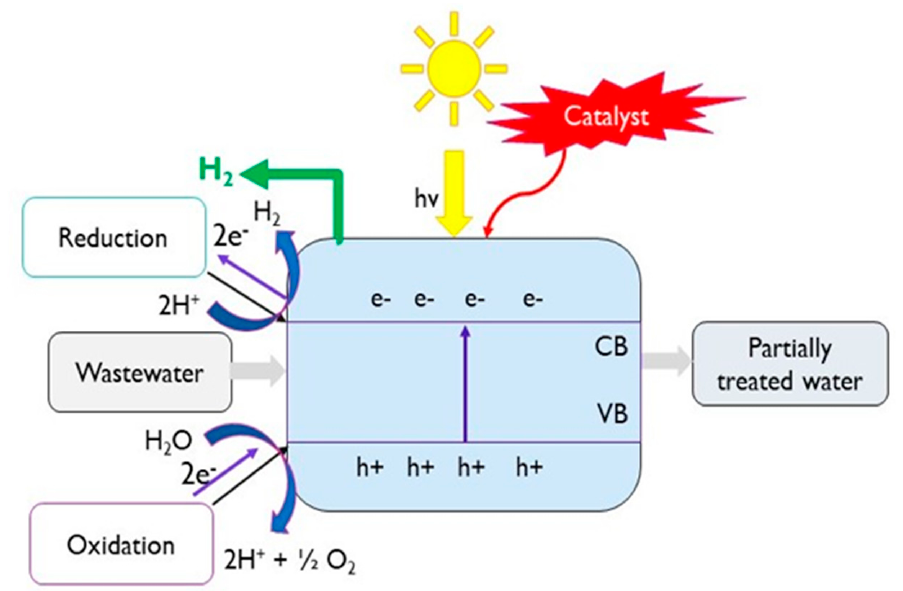
Figure 5. Schematic diagram of photocatalytic H 2 production.